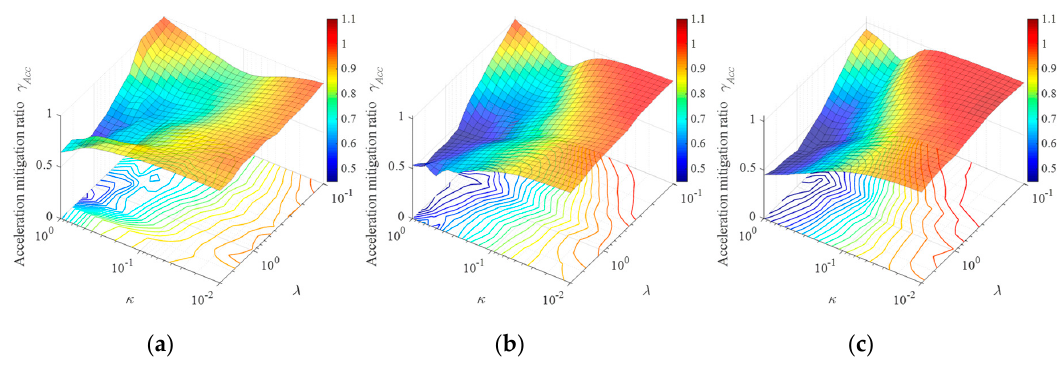
µ = 0.10, ( b ) µ = 0.20, and ( c ) µ = for (a) μ= 0.10 , (b) μ= 0.20 , and (c) μ= 0.30 . Figure 10. Variation of γ Acc Acc for ( a )